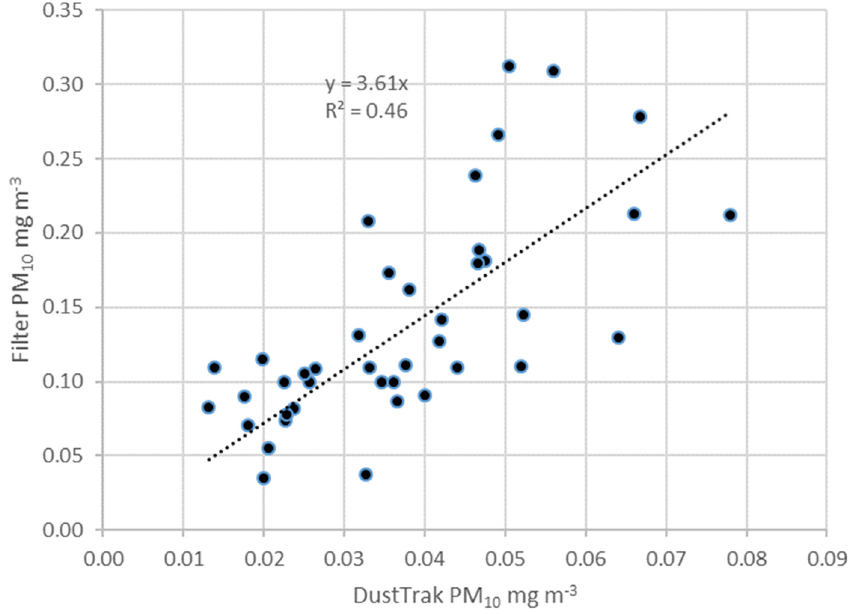
Figure 9. Comparison of filter-based and integrated DustTrak PM 10 concentrations for all test peri- ods.